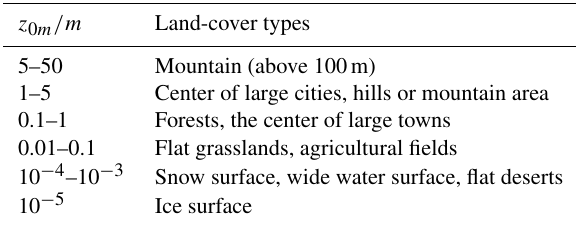
Table 1. Typical values of z 0 m corresponding to various land-cover